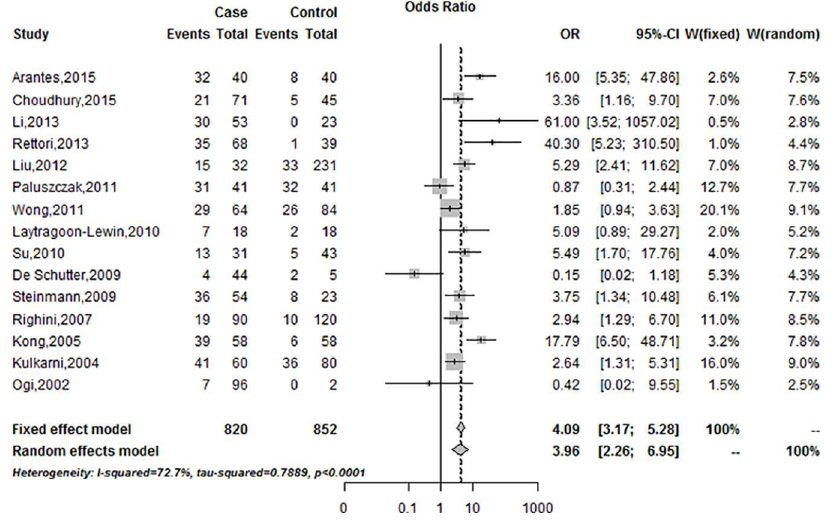
Fig 2. Forest plots of DAPK promoter methylation associatedwith